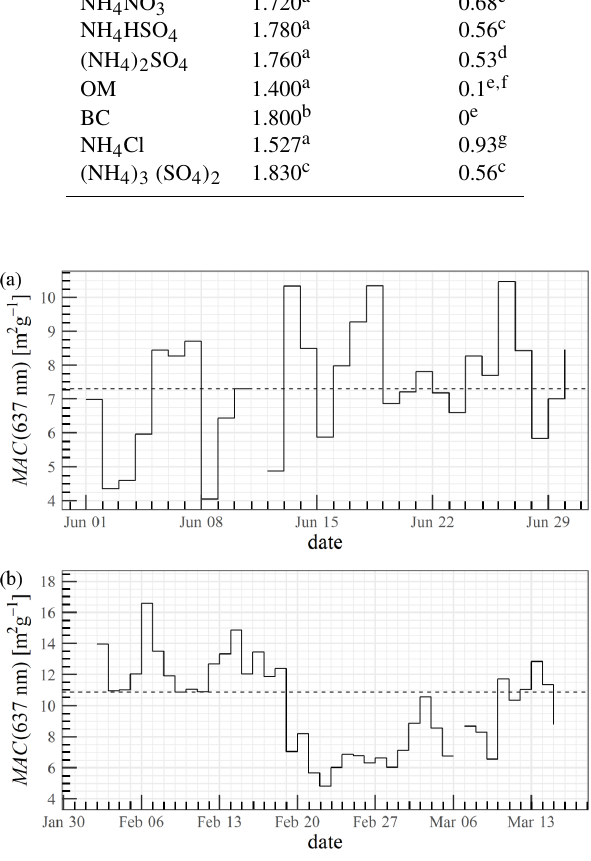
Figure A1. MAC (637nm) derived from measurements of the aerosol particle light absorption at 637nm and mass concentration of elemental carbon at Melpitz observatory. The horizontal dashed line indicates the median of the shown period. Panel (a) displays the period from 1 to 30 June 2015. Panel (b) displays 1 February